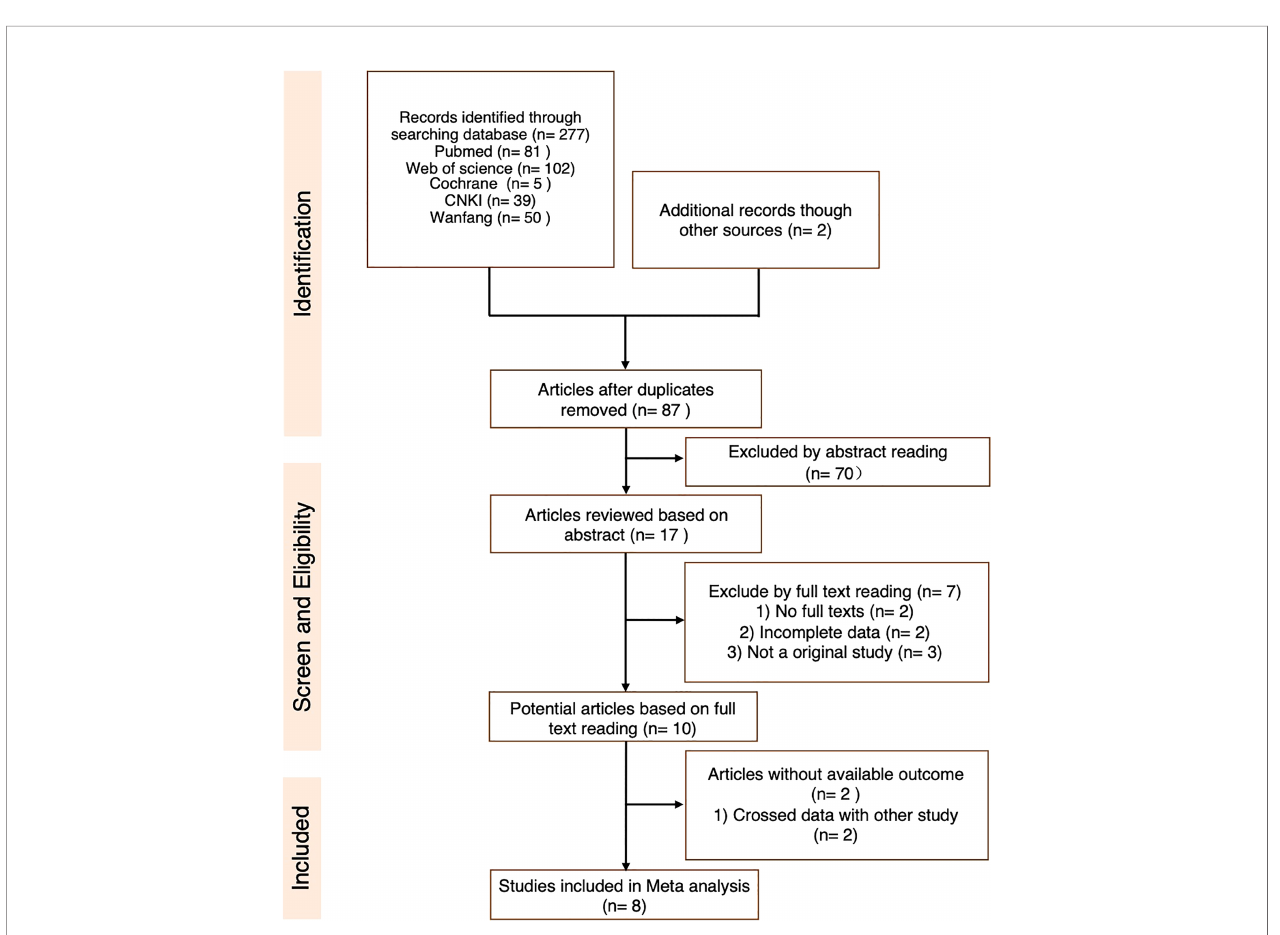
FIGURE 2 | Flowchart of the process of trial